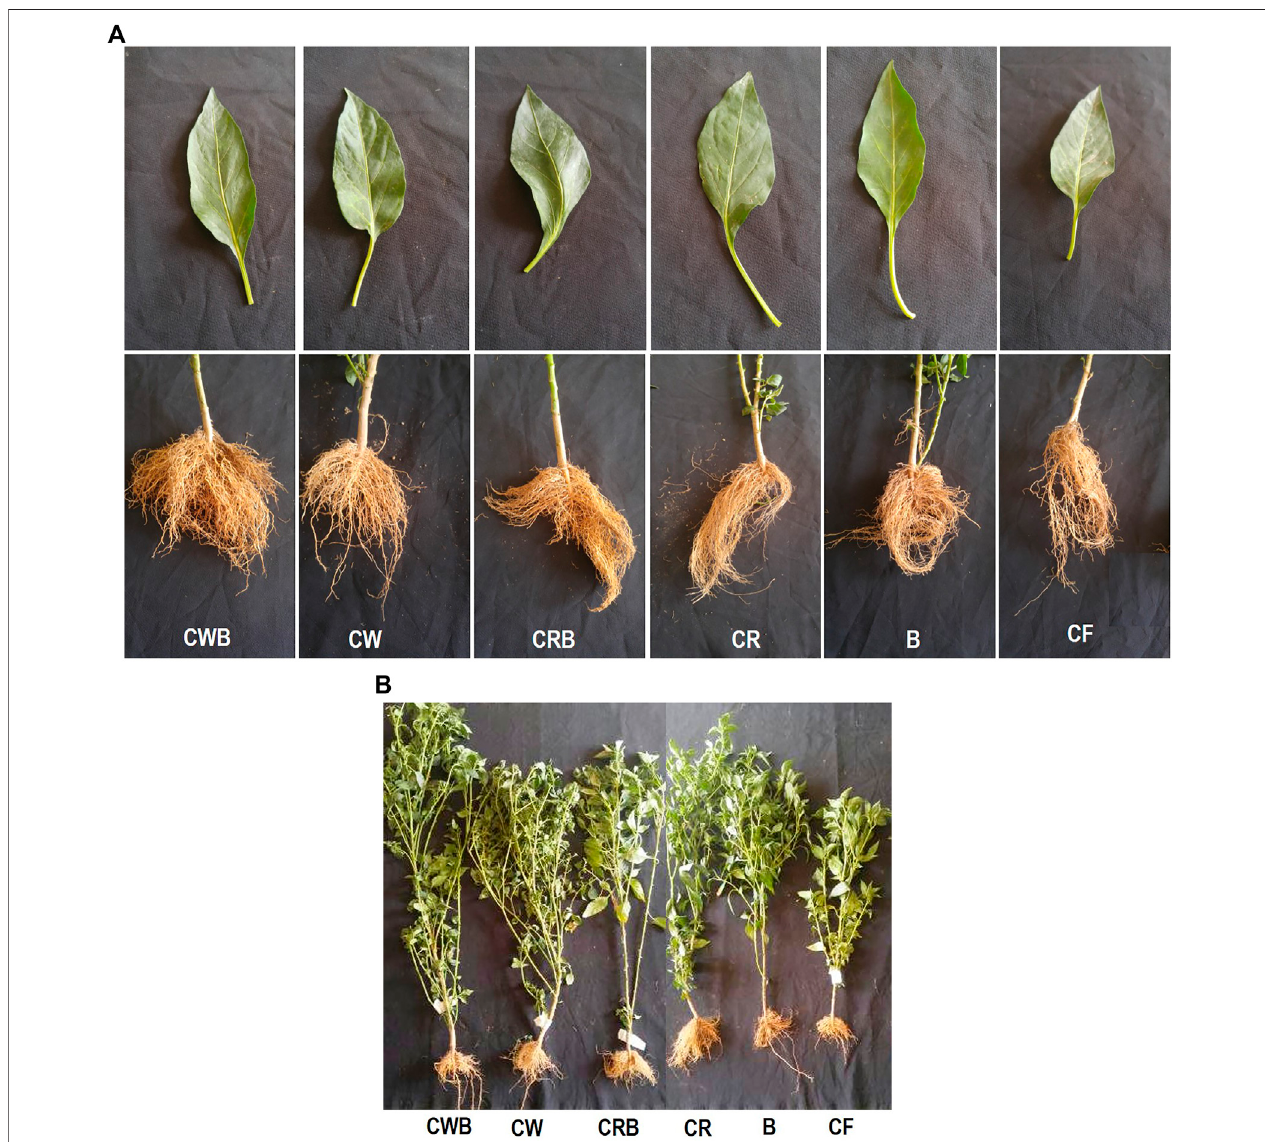
FIGURE 4 | (A) Inoculation response of rice and wheat compost and PGPR inoculum on the leaf and root growth of chilies compared with those grown in soil with chemical fertilizers. (B) Response of rice and wheat compost and PGPR inoculum on chilies ’ growth in pots compared with chili grown in soil with chemical fertilizers.